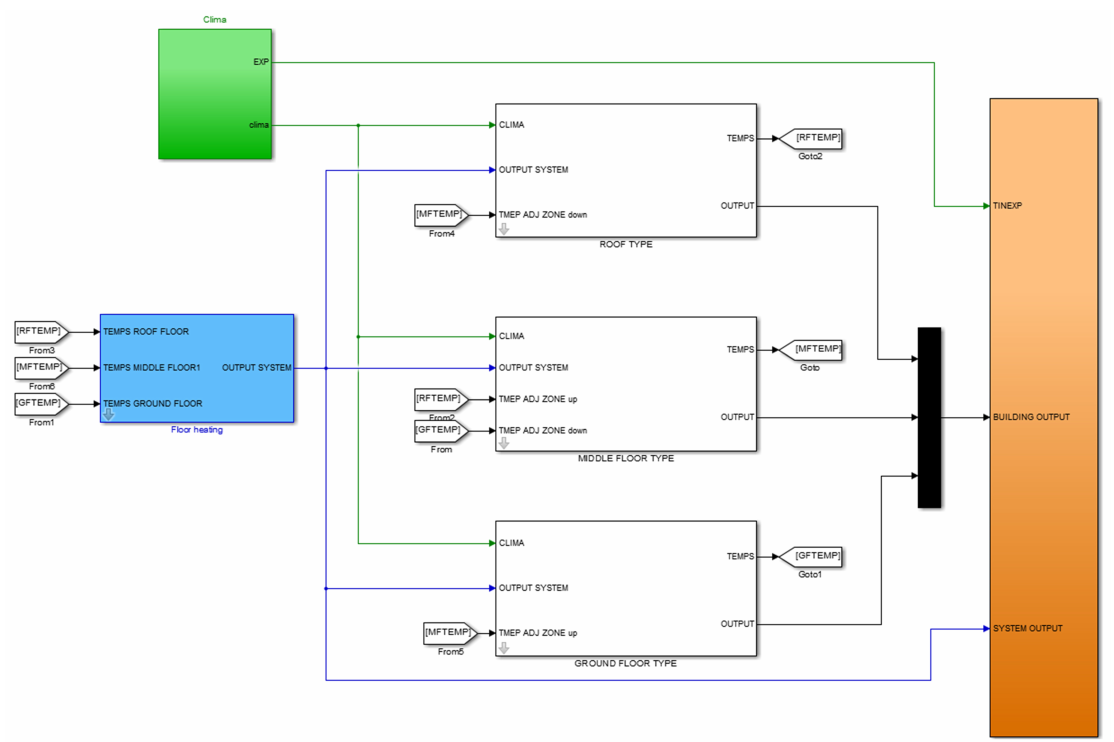
Figure 2. Building Energy Performance Simulator (BEPS) model developed for the Wüstenrot site using